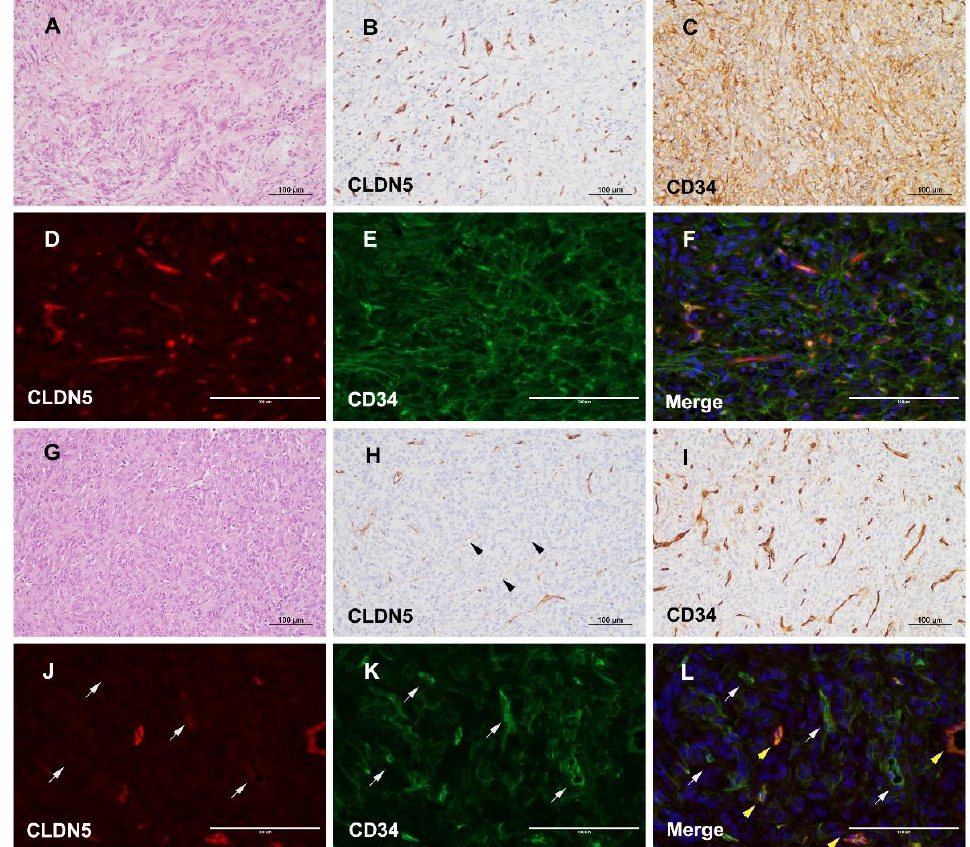
Figure 4. CLDN5 and CD34 expression in ic SFT/HPC and ex SFT/HPC. ( A – F ) Representative ex SFT/HPC case. H&E staining showed typical microscopic features of ex SFT/HPC ( A ). IHC staining showed moderate to strong expression of CLDN5, indicating well-preserved tight junctions of the tumor vasculature ( B ), and diffuse positivity for CD34 in ex SFT/HPC ( C ). Double immunofluorescence showed strong expression of CLDN5 ( D ), and diffuse expression of CD34 ( E ). Merged image showing tumor vessels with well-preserved coexpression of CLDN5 and CD34 in ex SFT/HPC ( F ) ( D – F , scale bar, 100 μ m). ( G – L ) Representative ic SFT/HPC case. H&E staining showed typical microscopic features of ic SFT/HPC ( G ). IHC showed some vessels with significantly decreased expression of CLDN5 (black arrowheads) ( H ), compared to densely labeled CD34 in tumor vessels of ic SFT/HPC ( I ). Double immunofluorescence revealed some tumor vessels where the expression of CLDN5 was markedly decreased ( J ) but the expression of CD34 was maintained (gray arrows) ( K ). Merged image showing good contrast between vessels stained for only CD34 (gray arrows) and other vessels with coexpression of CLDN5 and CD34 (yellow arrowheads) ( L ) ( J – L , scale bar, 100 μ m). 3.5. Reduced and Enhanced Expression of WNT5A and MMP9 in Extracranial Metastatic Lesions of icSFT/HPC